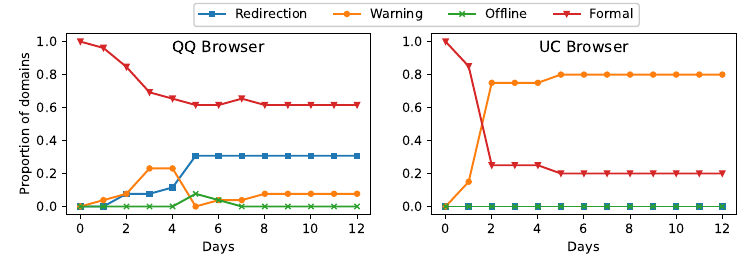
Figure 11. Browser response time for handling abusive domain